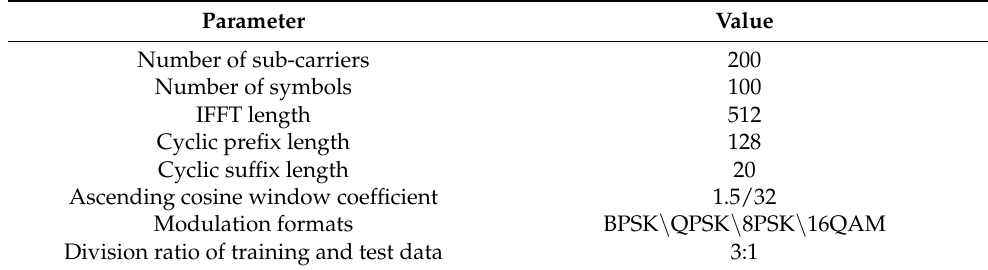
Table 1. Parameters in the